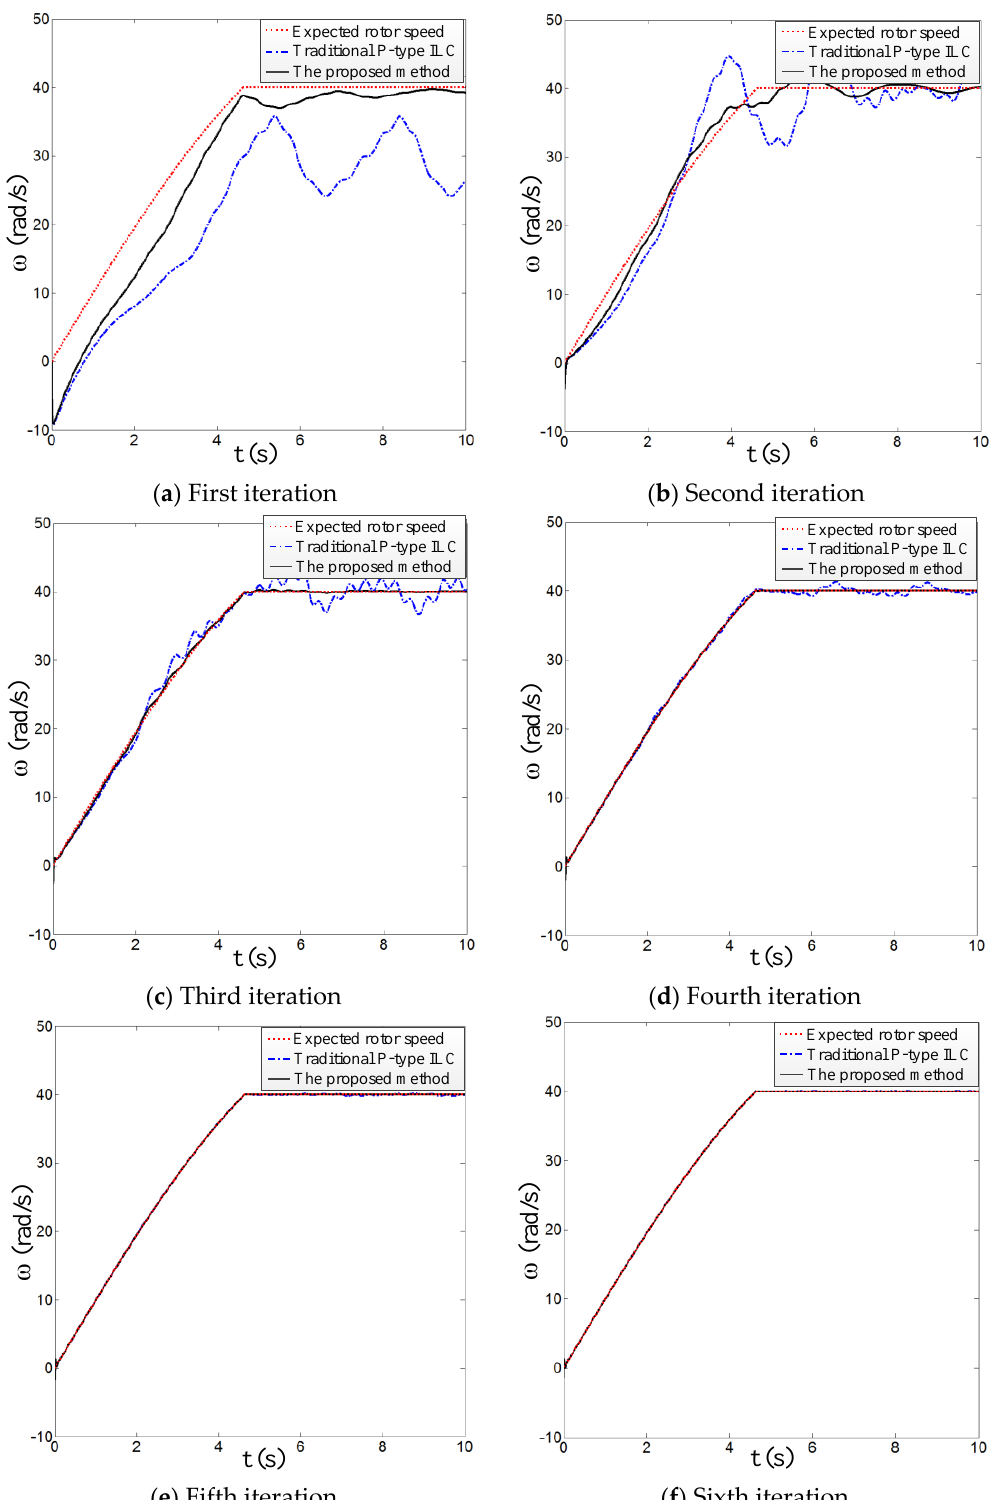
Figure 2. Tracking curve of the motor angular speed in the simulation.